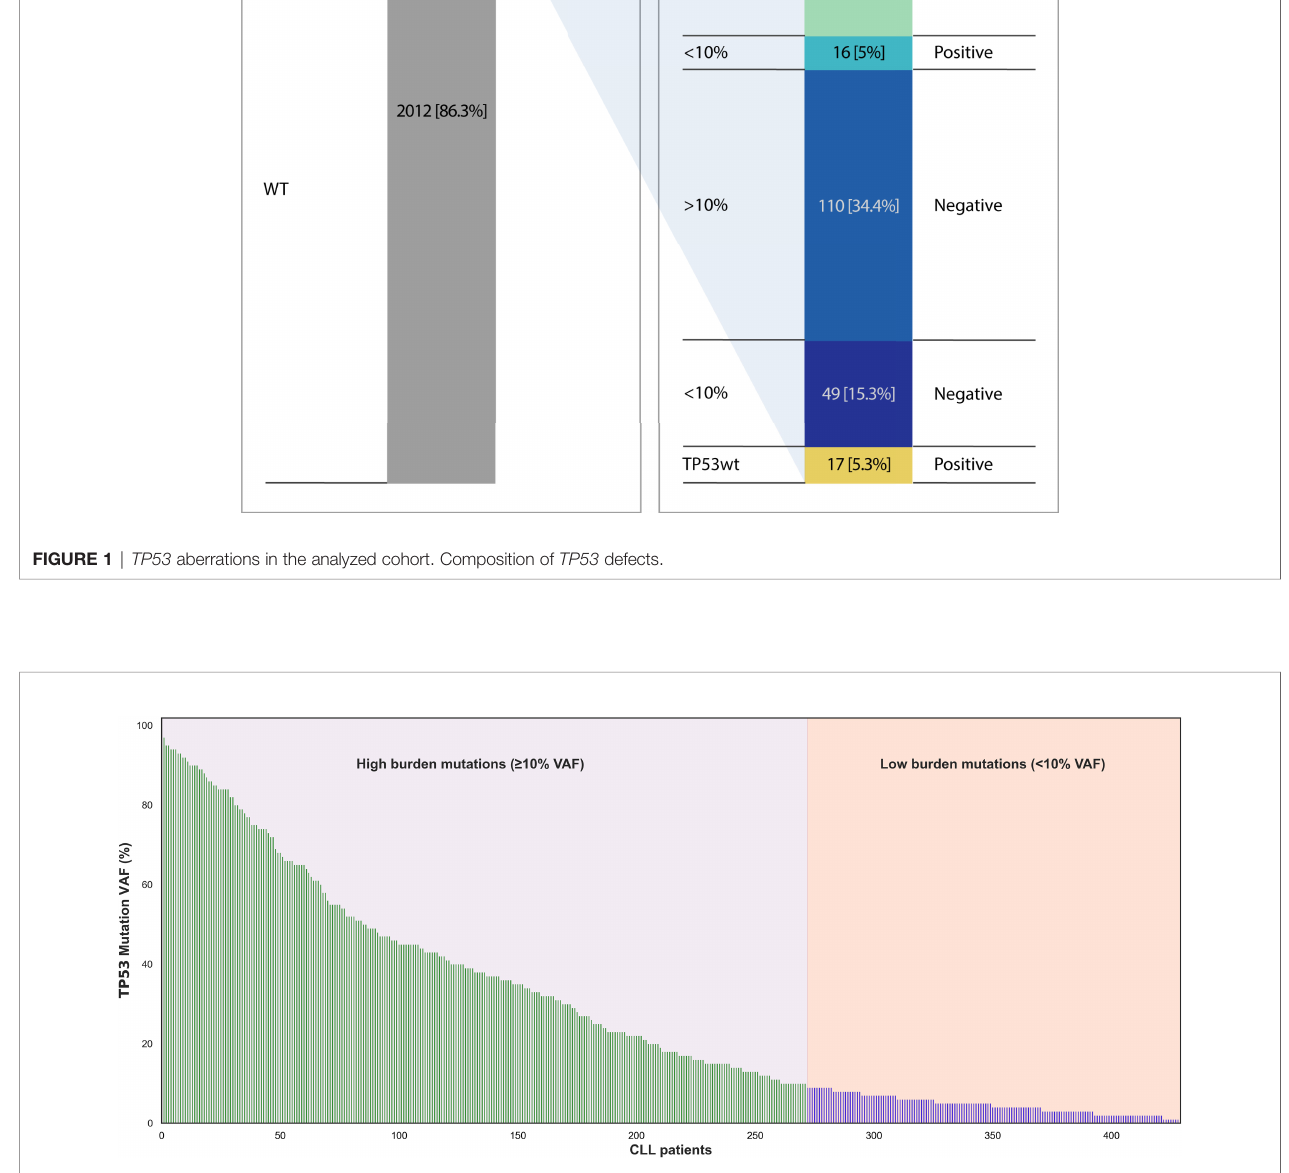
FIGURE 2 | Molecular Pro fi le of TP53 mutations in the cohort. Using a cutoff of 10% VAF 271 TP53 mutations (228 patients) had high burden mutations and 158 TP53 mutations (65 patients) had low burden mutations.